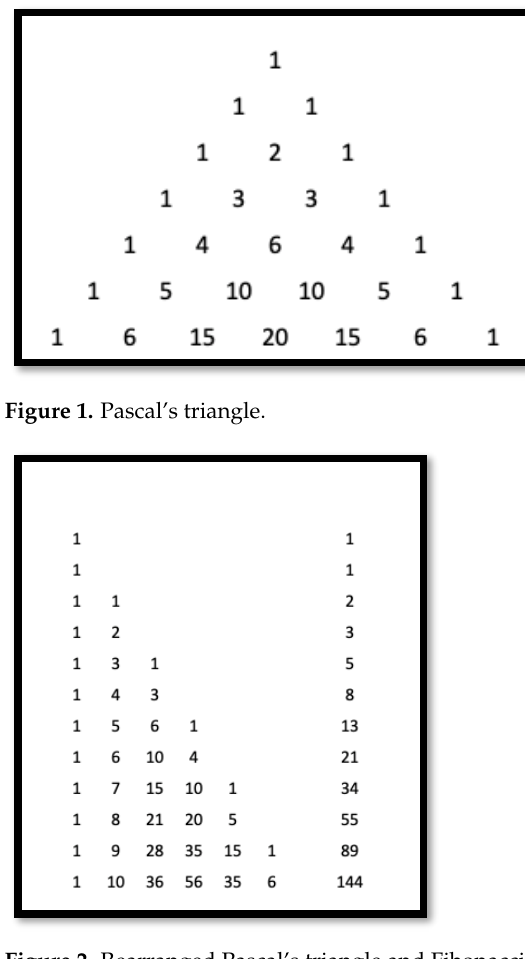
Figure 2. Rearranged Pascal’s triangle and Fibonacci numbers.